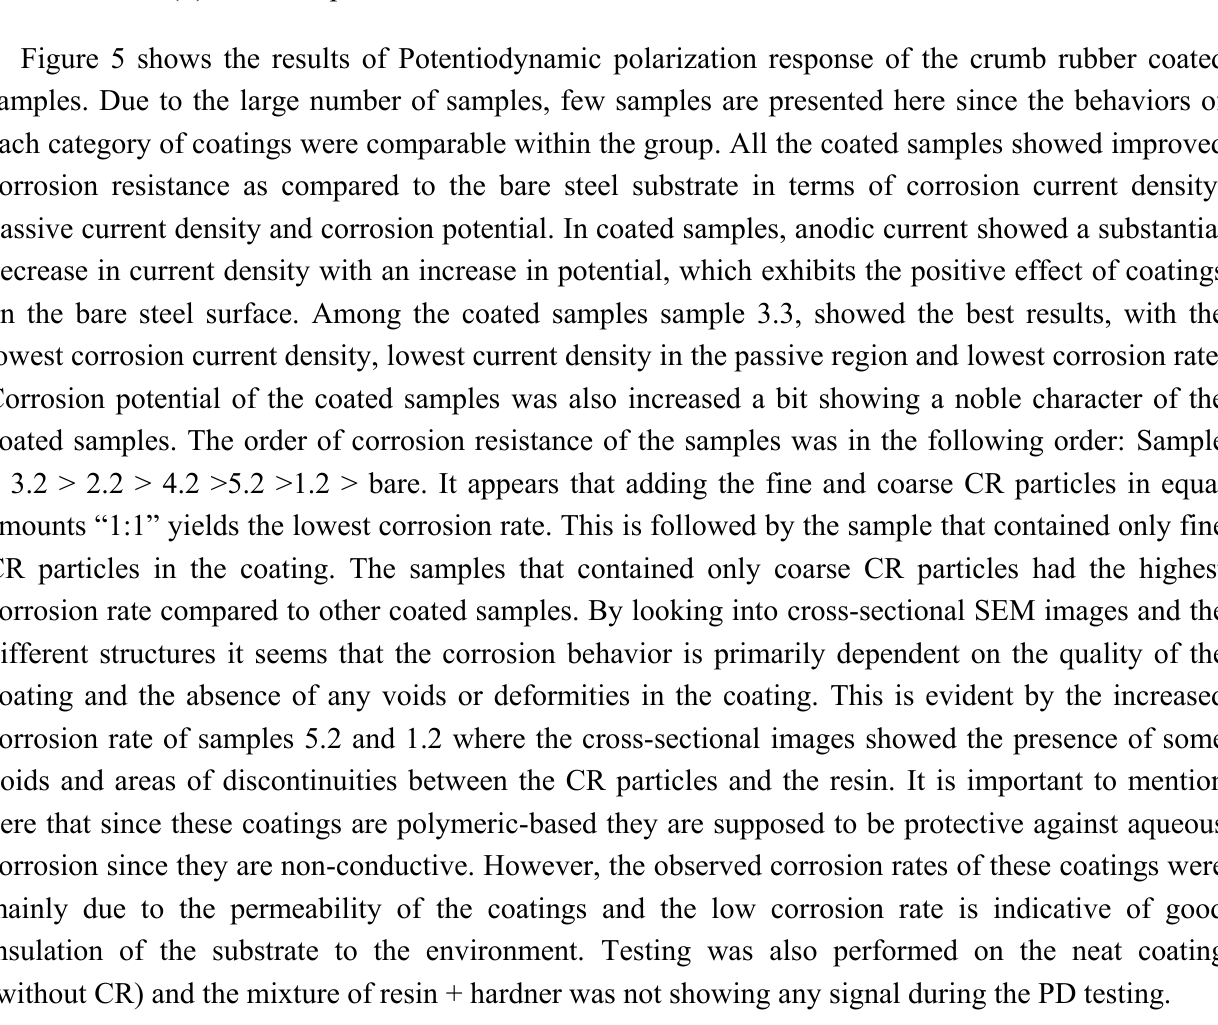
Figure 4. SEM images of eroded surfaces of coatings ( a ) 24% coarse/fine particles at 4:1 ratio and ( b ) 50% fine